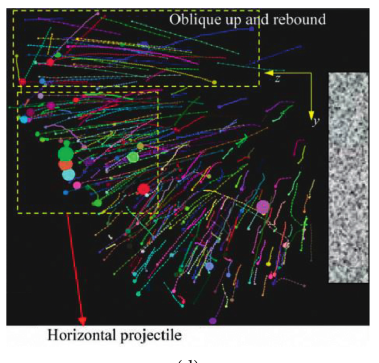
Figure 15: Ejection paths of typical pre-heated specimens during strain burst: (a) 25 ° C; (b) 50 ° C; (c) 100 ° C; (d) 150 ° C [28].